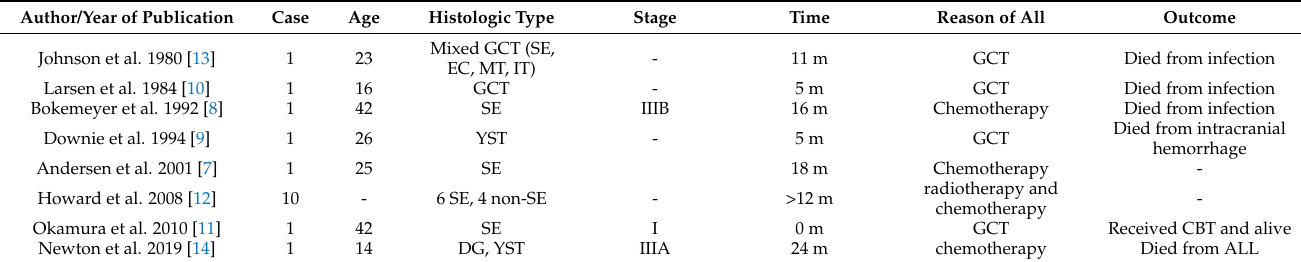
Table 1. Acute lymphoblastic leukemia reported in